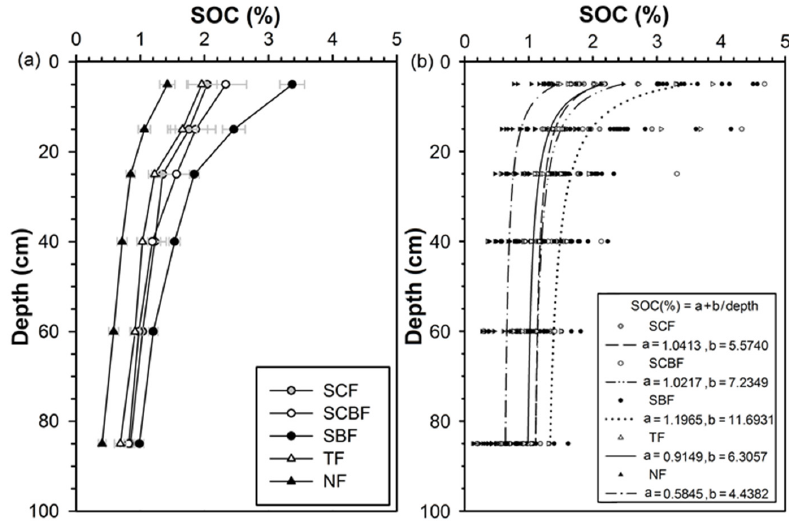
Figure 5. ( a ) Vertical distributions of soil organic C (SOC) (%) of the soil profiles at six levels, ranging from 0 to 100 cm depths; ( b ) Simulated models of the relationship between depth (cm) and SOC (%).